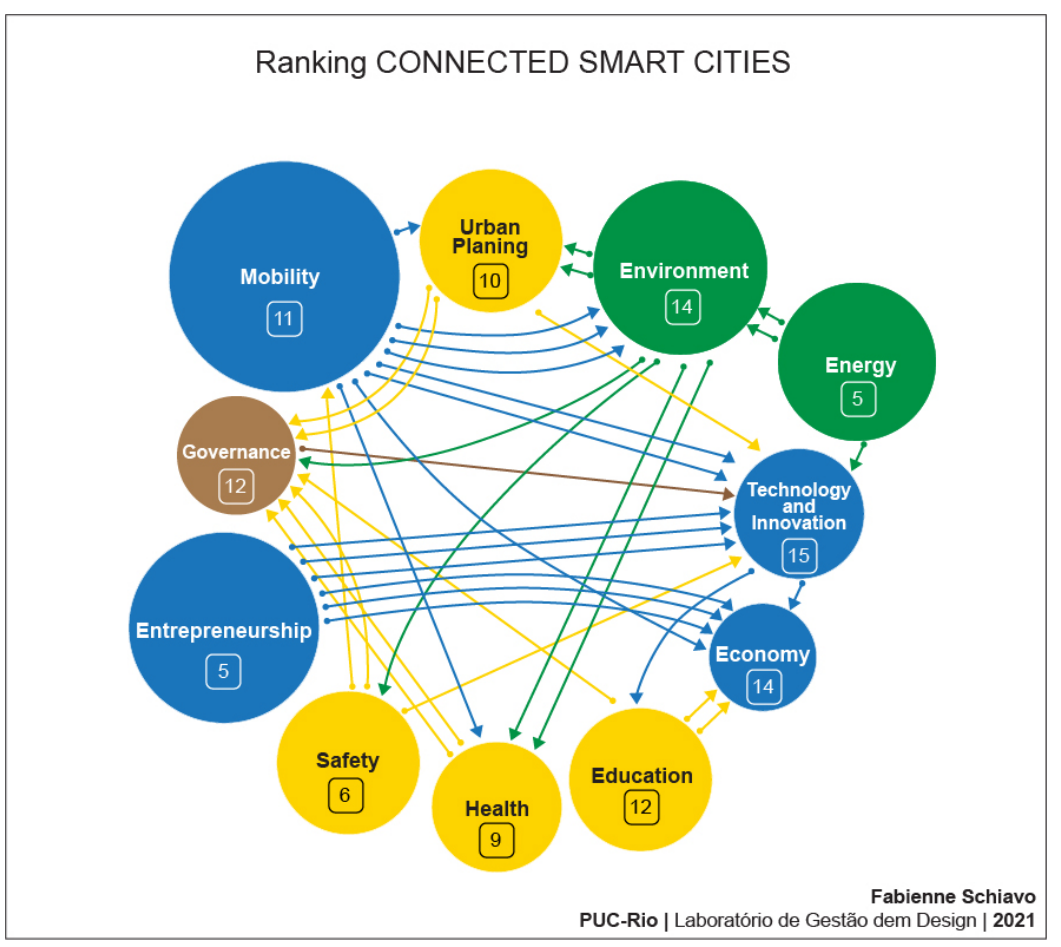
Figure 9. Themes and influences within the Connected Smart Cities ranking. Source: Connected Smart Cities Report [117]. Influence chart created by the author.